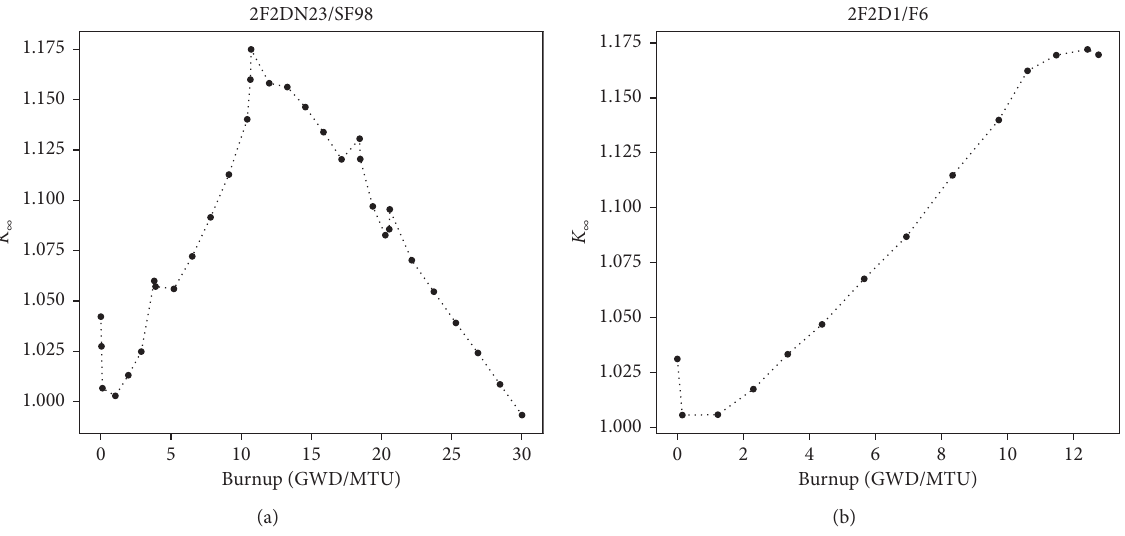
Figure 7: Variation of assembly k